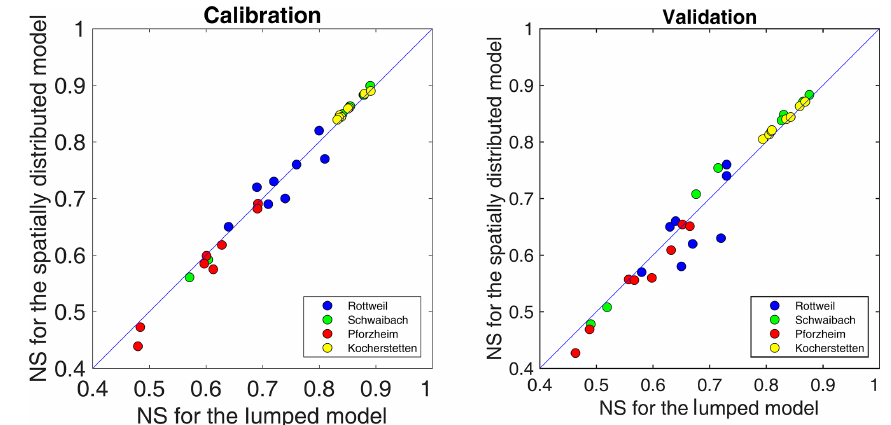
Figure 13. Comparison of the NS coefficient for different spatial resolutions of model structure.